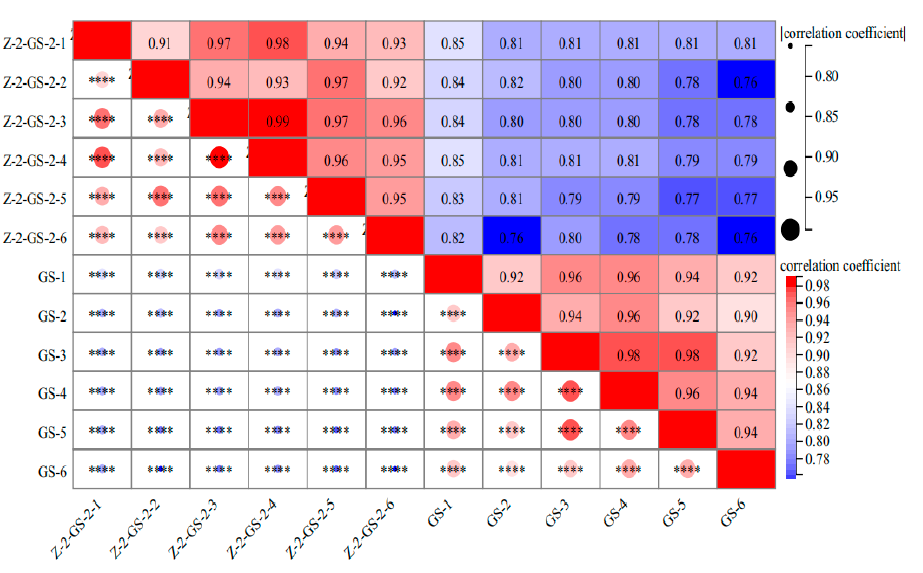
Figure 9. Correlation analysis matrix of GS and Z-2-GS-2 group-targeted amino acid metabolites. Note: the GS group represents Vigna angularis without the spraying of FSA and the Z-2-GS-2 group represents Vigna angularis under FSA stress; **** Indicates the level of significance.